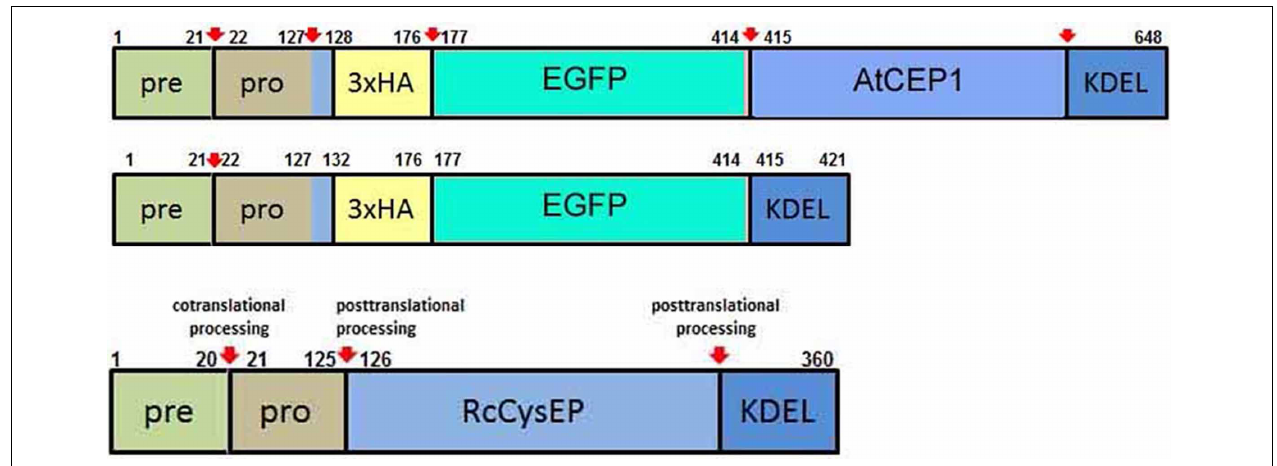
FIGURE 3 | Schematic representation of the functional reporter protein pre-pro-3xHA-EGFP-AtCEP1-KDEL and the non-functional reporter protein pre-pro-3xHA-EGFP-KDEL expressed under the control of the